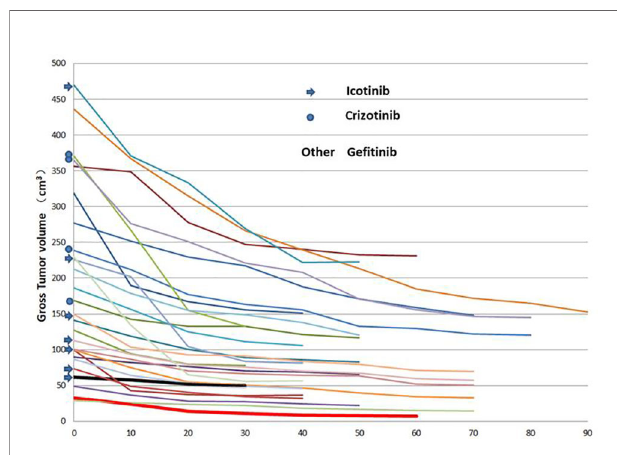
FIGURE 1 | Changes in the primary tumour volume at different times after targeted therapy in